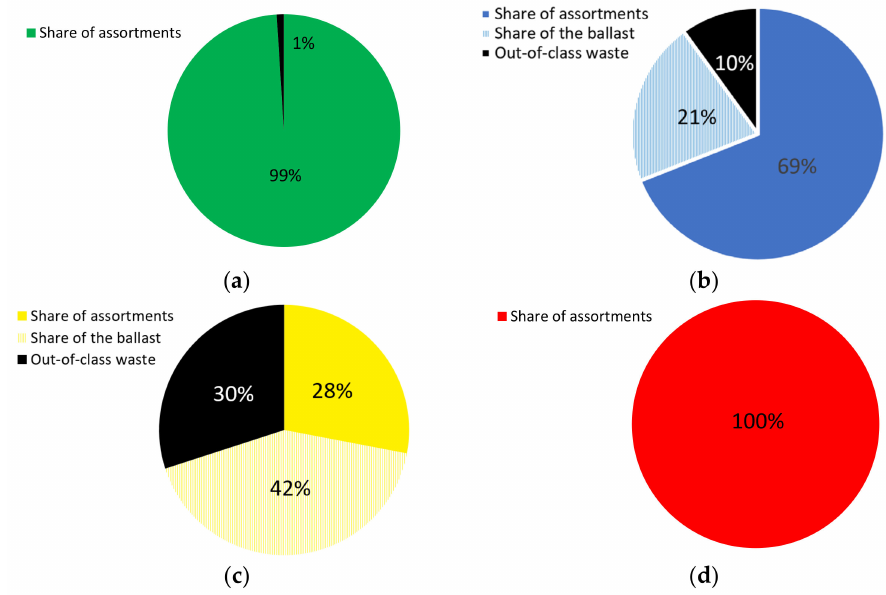
Figure 9. Quality of selectively collected individual waste fractions—values for 2020; ( a ) glass; ( b ) paper and carboard; ( c ) plastic; ( d )